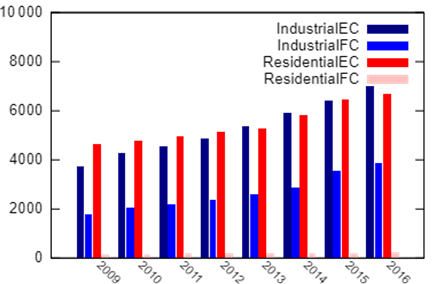
Figure 5. Annual CO 2 emissions (unit: Gg) of electricity consump- tion (EC) and fuel consumption (FC) of manufacturing industry and residential sector in HCMC from 2009 to 2016.